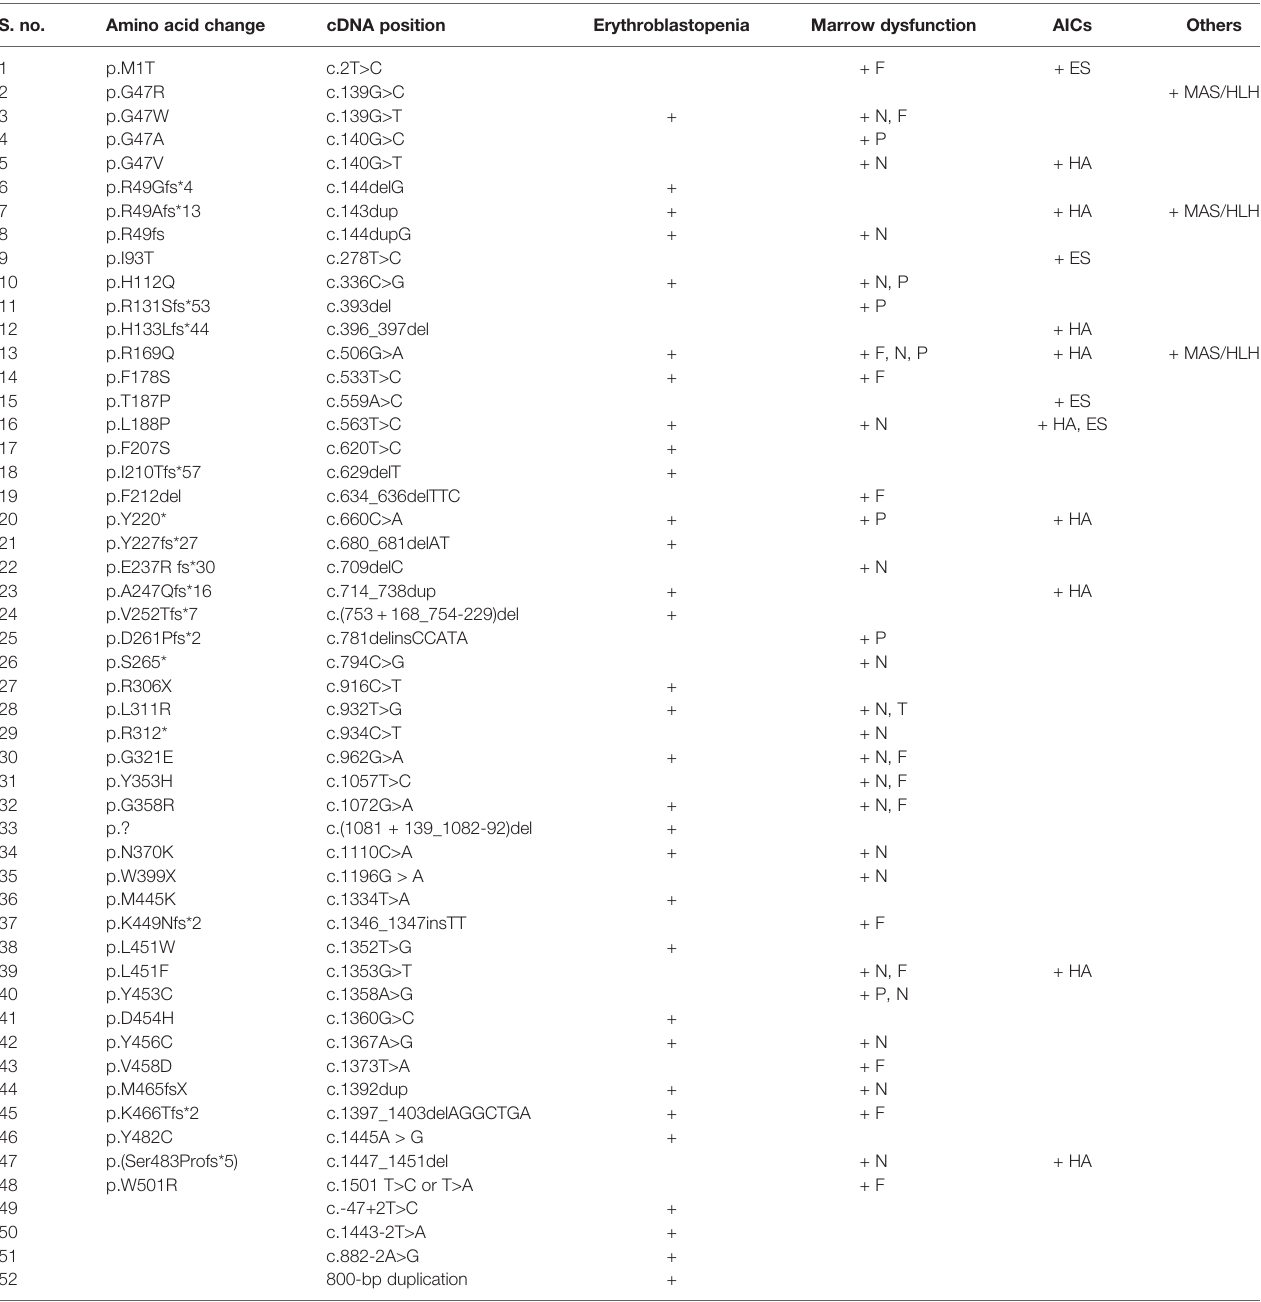
TABLE 1 | Variants associated with haematological